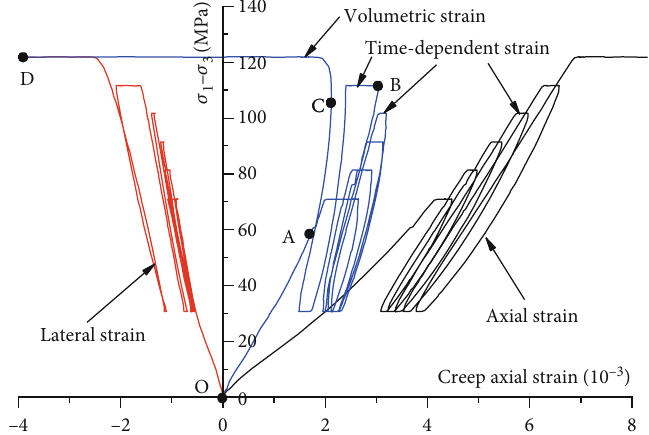
= 6MPa , Δ P = 1 : 9 MPa 3